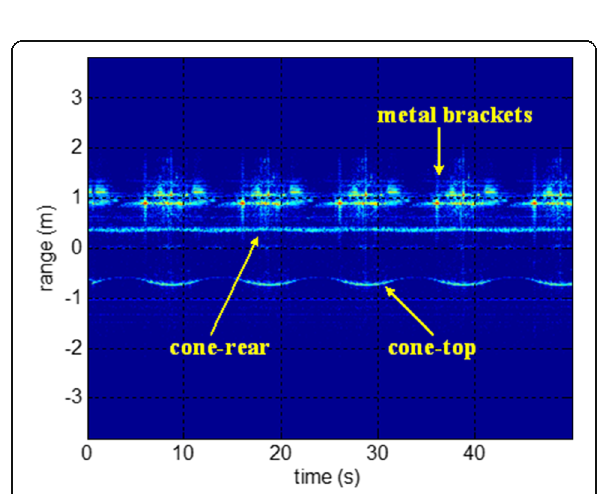
Fig. 13 The range profile sequence of the precession warhead